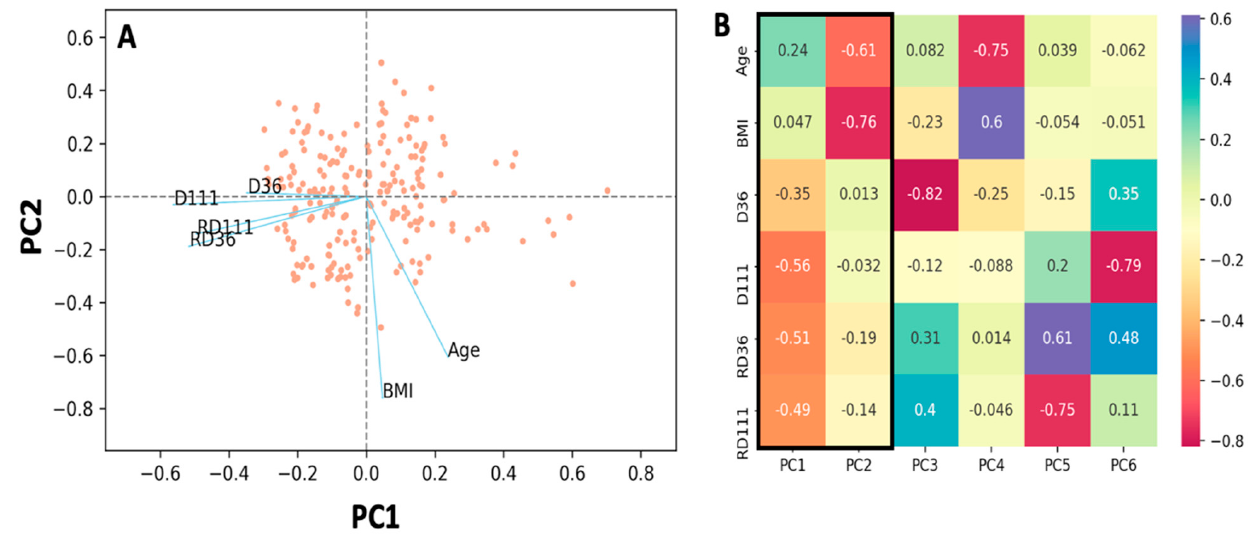
Figure 6. Principal component analysis of the percent inhibition of SARS-CoV-2 binding (D36, D111) and anti-S-RBD levels (RD36, RD111) at two occasions (day 36 and 111) and two subjects’ characteristics: body mass index (BMI) and age. ( A ) Biplot of the two principal components (PC) showing the individual scores and the loadings (blue lines) of the six characteristics. ( B ) Loadings for the entire 6 PCs. The two first PCs, inside the thick border, are plotted in ( A ).